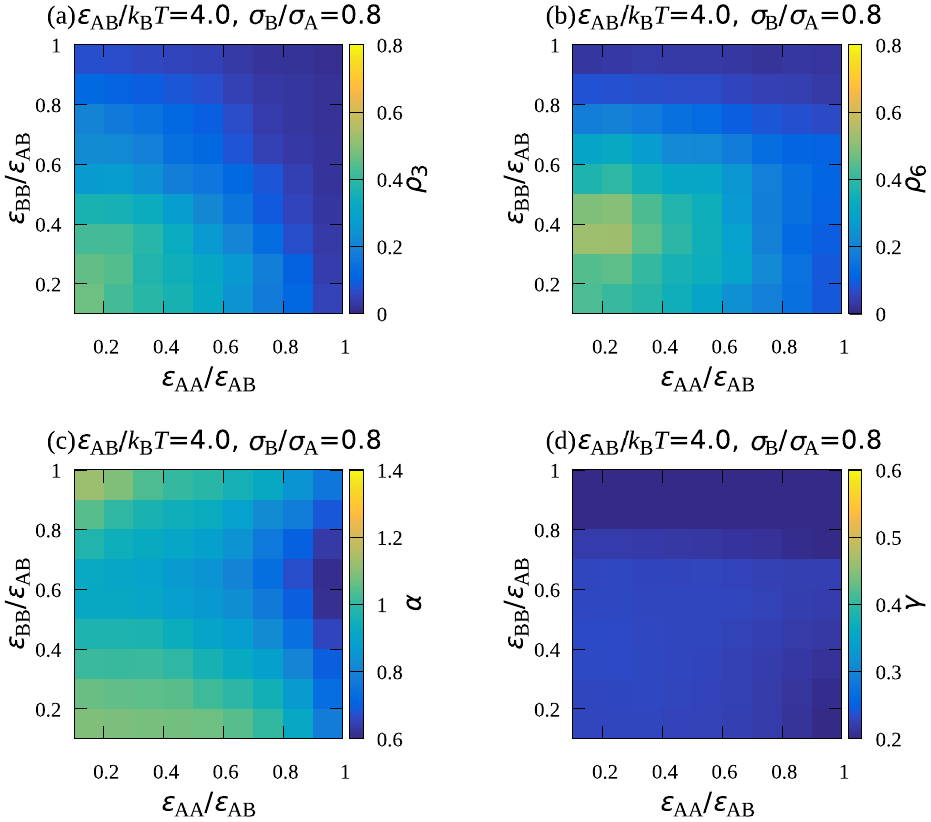
Figure 8. Dependence of ( a ) ρ 3 , ( b ) ρ 6 , ( c ) α , and ( d ) γ on ε AA /ε AB and ε BB /ε AB , where ε AB / k B T = 4.0 , σ B /σ A = 0.8 , and ρ = 0.2 . ρ 3 and ρ 6 represent the ratios of highly ordered B particle and A particle to all the particles attached to the bottom wall, respectively, α shows how the composition ratio of A particles on the bottom wall is higher than that in the system, and γ shows the ratio of the number of particles attaching to the wall to that of all the particles in the